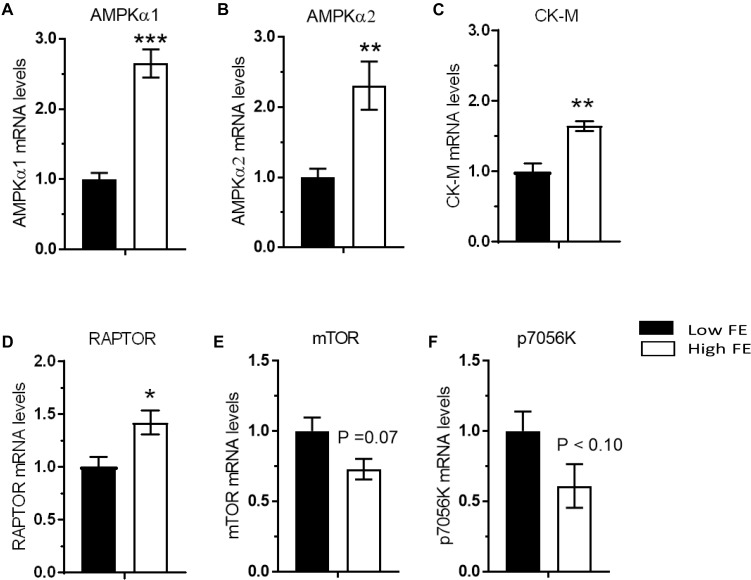
Differentially expressed genes that are involved inmuscle metabolism (energy sensing/storage), and protein synthesis via nutrient sensing in breast muscle from Pedigree Male (PedM) broilers exhibiting high or low feed efficiency (FE) phenotype. Relative expression of mRNA is shown for AMP-activated protein kinase alpha subunits 1 and 2 (AMPKα1) (A) and AMPKα2 (B), creatine kinase muscle isoform (CKM) (C), regulatory-associated protein of mTOR (RAPTOR) (D), mechanistic target of rapamycin (mTOR) (E), and 70 kDa ribosomal protein S6 kinase (P70S6K) (F).